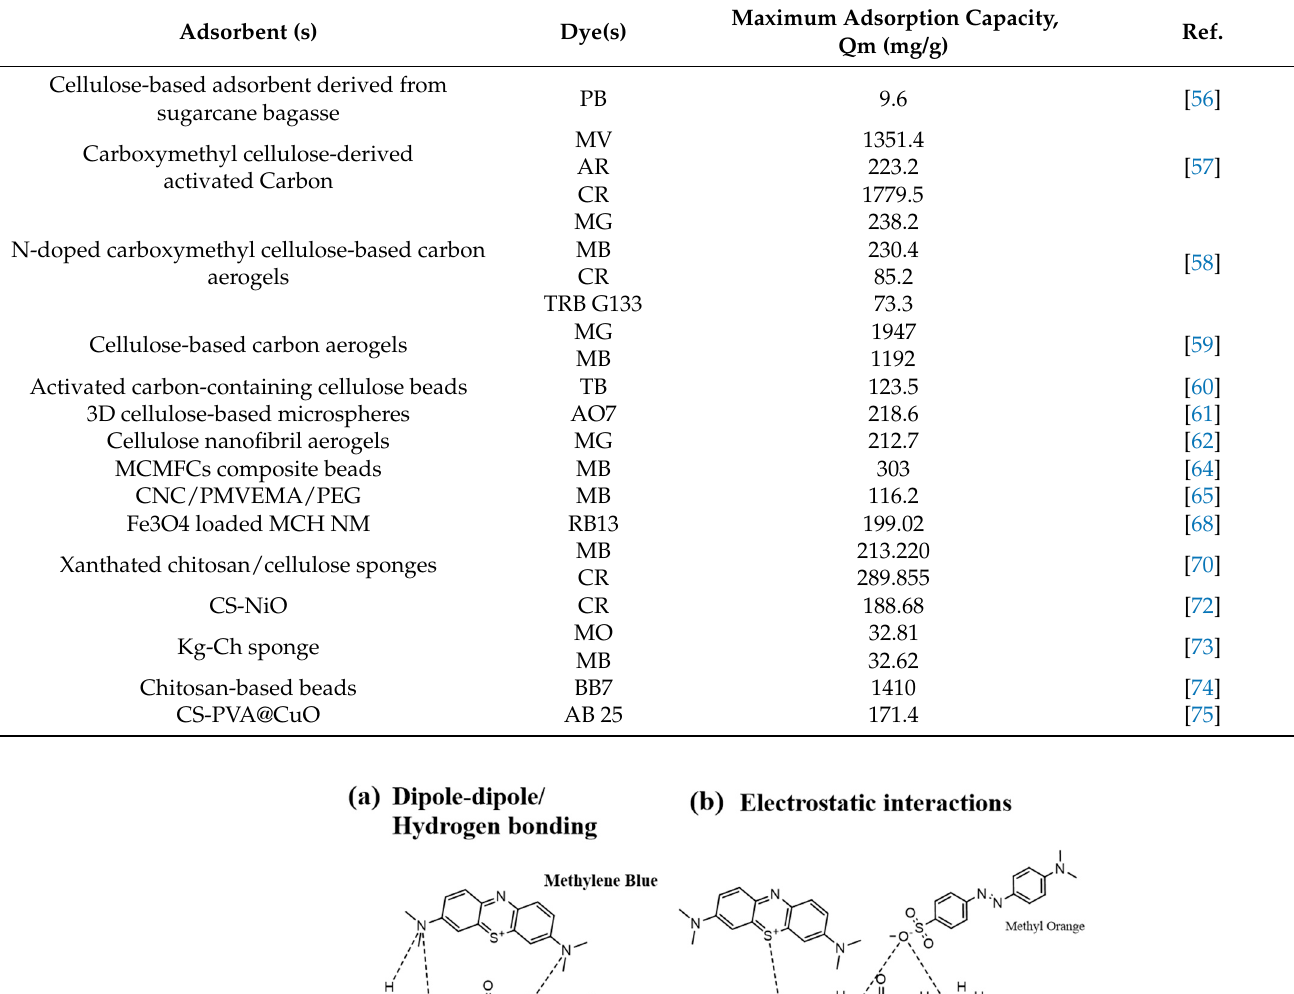
Table 2. Adsorption of industrial dyes using biopolymer-based adsorbents.